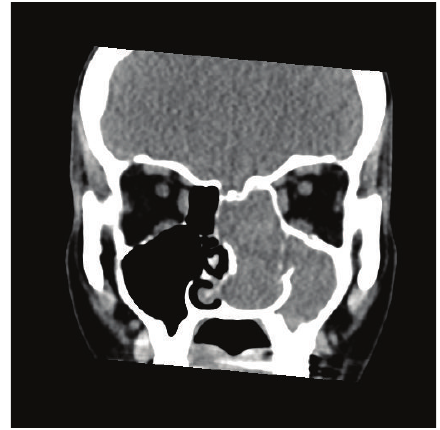
Figure 2: CT (coronal view).